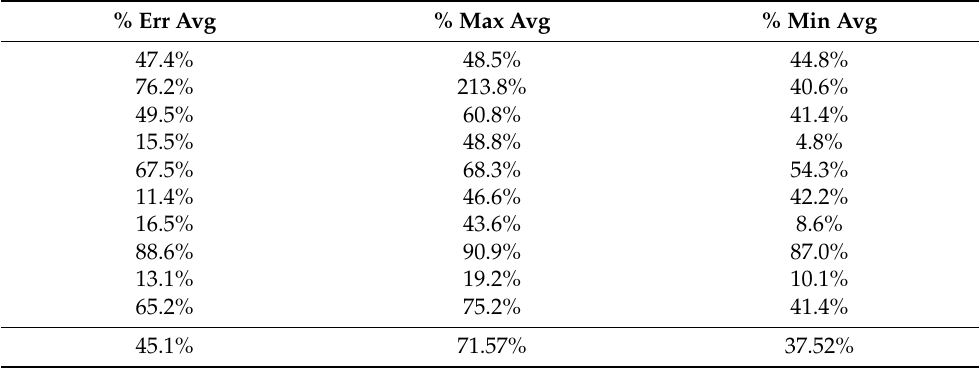
Table A71. Set 1, trials 41–50 data (single 0.5 PR